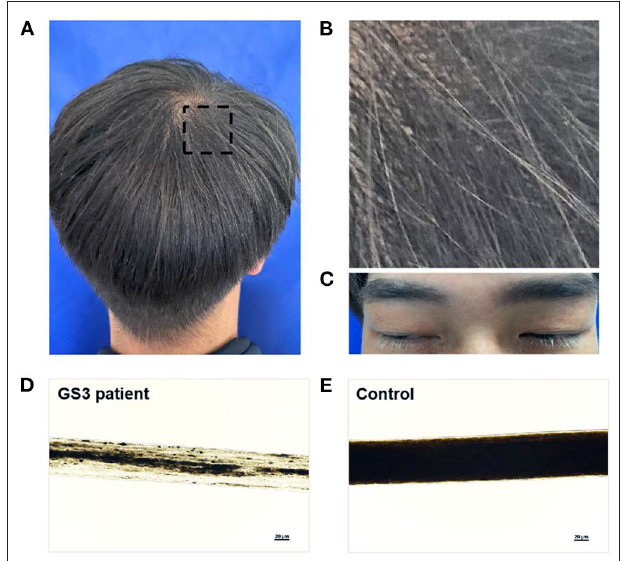
FIGURE 1 | Hair phenotypes of a patient with Griscelli syndrome type 3 (GS3). (A,B) A mixture of dark brown and silvery-gray hair in a 32-year-old man with GS3. The black rectangular frame is enlarged in (B) . (C) Dark gray eyebrows and white eyelashes of the patient. (D,E) Light microscopy images of the hair shafts, showing the irregular clumping of melanin in the patient’s hair shaft (D) , and the even distribution of melanin in the hair shaft from a normal black hair individual (E) . The magnification of the objective lenses was × 20. Written informed consent was obtained from the patient for publication of the pictures (A–C)